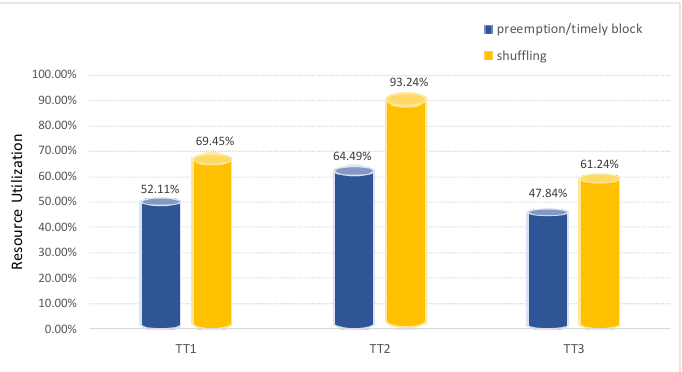
Figure 13. Resource utilization under different traffic integration